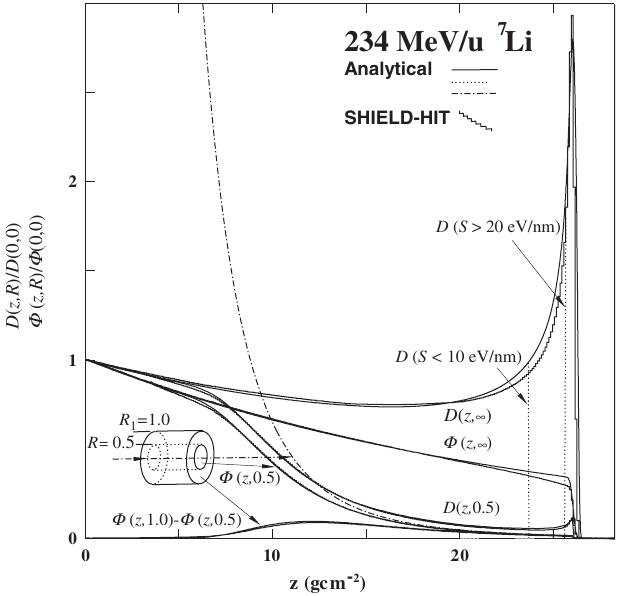
=(cid:7) 1 and (cid:4) =(cid:7) 2 , correspond to the (cid:7) 1 (cid:7) 2 Cutoff